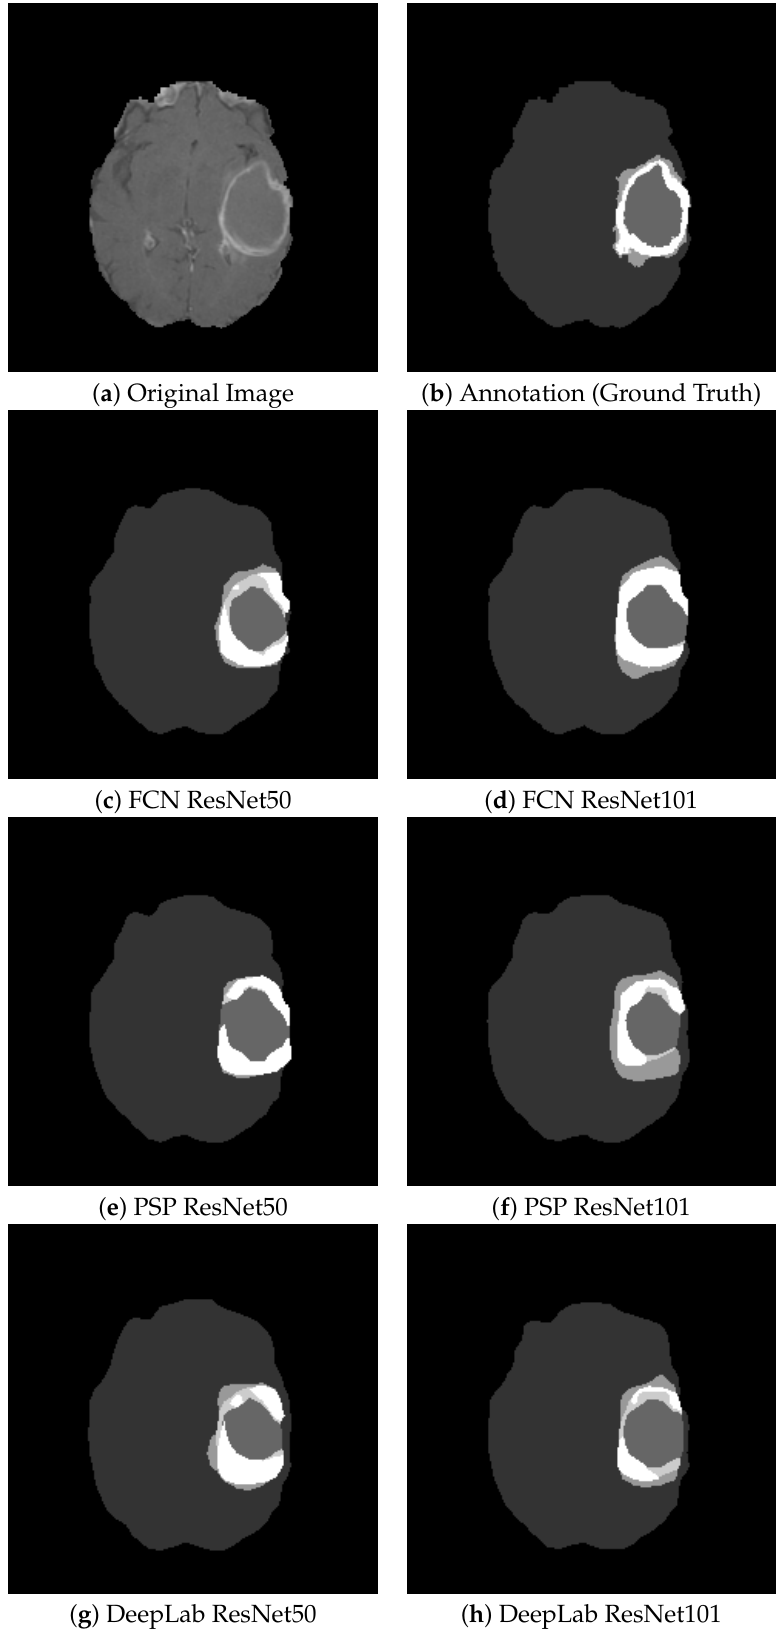
Figure 10. Segmentation Results of the 6 Architectures: visually, the segmentations are similar, and the difference on average for the whole dataset is about